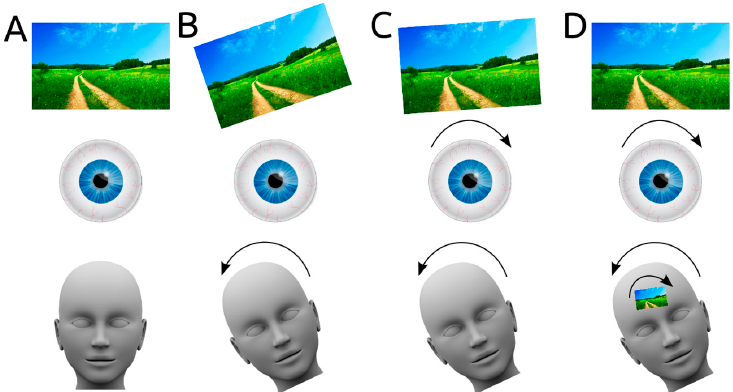
Figure 1. ( A ) When the head is in an upright position, so are the eyes and the visual world. ( B ) If the eyes were to remain upright with respect to a rolling head, the visual world would tilt. ( C ) Due to the vestibulo-ocular reflex, the eyes rotate in the opposite direction of the rolling head. This counteracts most of the rotation of the visual field. ( D ) Some authors have argued that vestibular input is also processed centrally, to directly tilt visual fields.